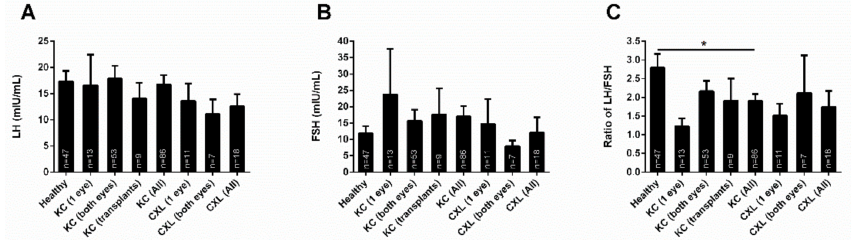
Figure 6. Expression of LH and FSH, and the LH / FSH ratio in healthy (n = 47) and KC (n = 86) blood (plasma) samples. Seven di ff erent groups were compared: (1) KC on one eye (n = 13), (2) KC on both eyes (n = 53), (3) KCs with corneal transplants (n = 9), (4) All KCs independent of treatment(s) (n = 86), (5) KCs with collagen crosslinking on one eye (n = 11), and (6) KCs with collagen crosslinking on both eyes (n = 7), and 7) All KCs with collagen crosslinking treatment, independent of the number of eyes (n = 18). ( A ) LH levels, ( B ) FSH levels, and ( C ) the LH / FSH ratio. * p < 0.05. (See Supplementary Materials—Figure S6).